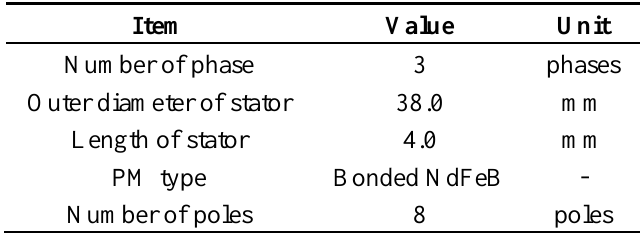
Table 1. Specifications of the proposed stepper